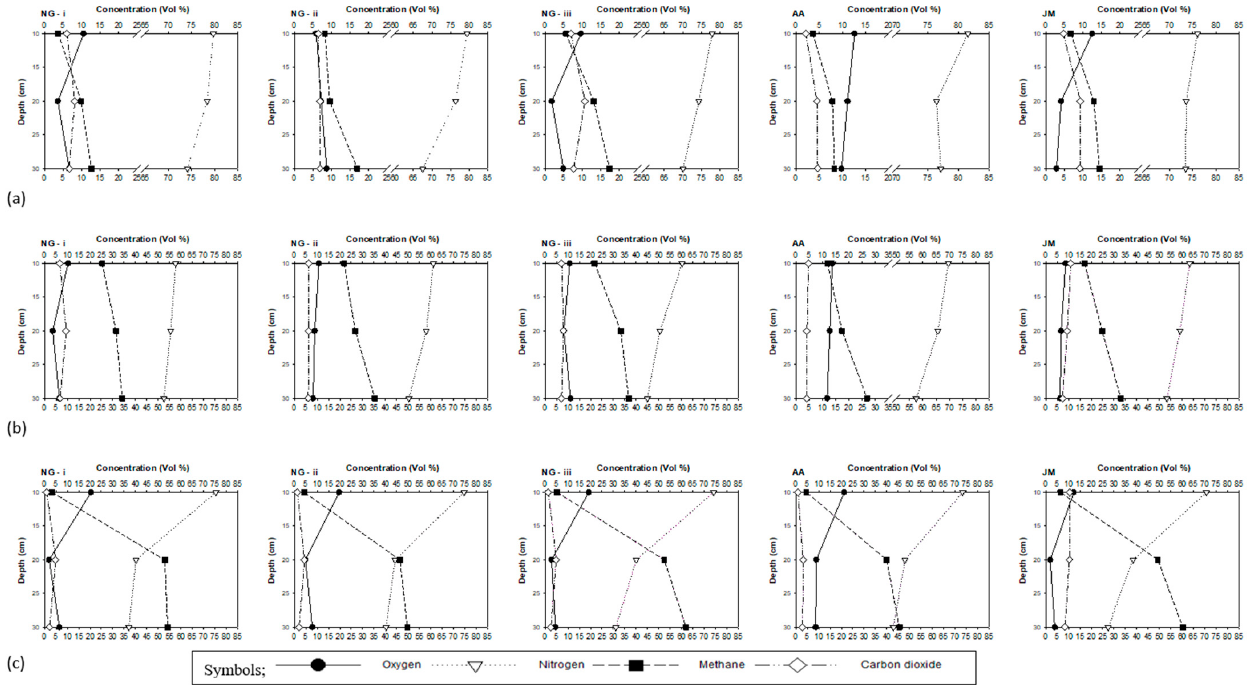
Figure 5. Depth profiles of the columns exposed to gas: NG-i, NG-ii, and NG-iii (native grass triplicates), AA—alfalfa, JM—Japanese millet, at different CH 4 loading rates. ( a ) CH 4 loading rate of 75.1 gCH 4 /m 2 /d on day 7, ( b ) CH 4 loading rate of 437.9 gCH 4 /m 2 /d on day 41, ( c ) CH 4 loading rate of 845.2 gCH 4 /m 2 /d on day 65.